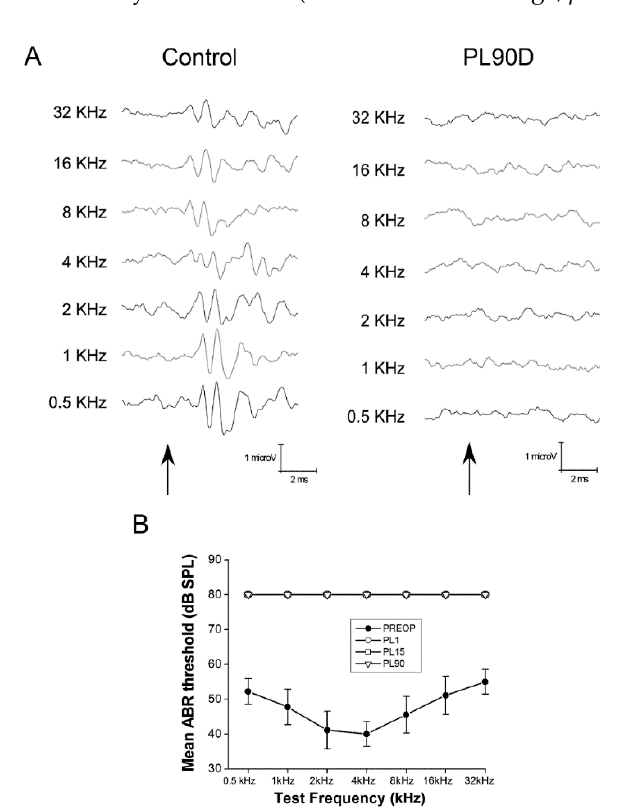
Figure 1. Hearing loss after the cochlear lesion. ( A ) Representative ABR recordings, spanning 0.5–32 kHz, from a control rat and a rat surviving 90 days after bilateral cochlear lesion. Arrows represent the beginning of stimuli. There are no recordable activity waves at any tested frequency at the highest intensity stimulus of 80 dB SPL 0.5 kHz to 32 kHz, see materials and methods). ( B ) ABR thresholds right before the cochlear lesion (pre-op) and 1 day (PL1), 15 days (PL15) and 90 days (PL90) after the lesion. The flat line indicates undetectable thresholds from day 1 after the lesion onwards at 80 dB SPL, the highest sound intensity used.